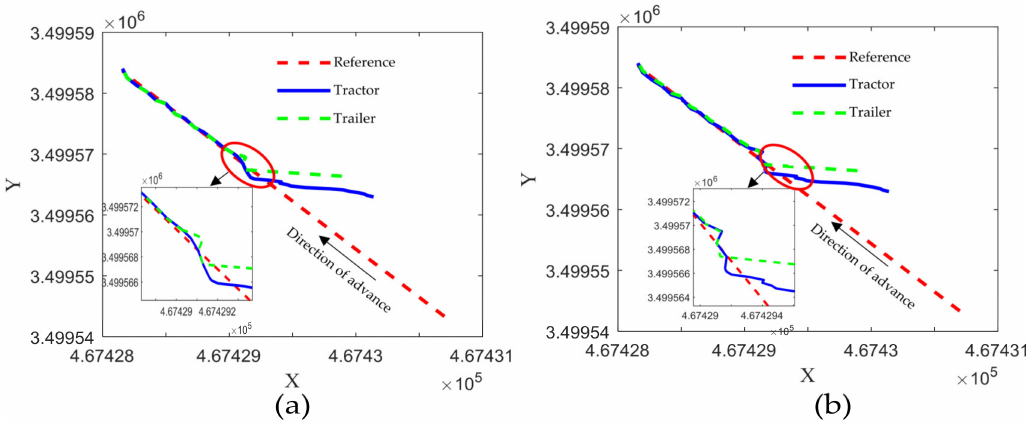
Figure 7. The driving trajectories of the tractor-trailer: ( a ) FSMC; ( b ) SMC.